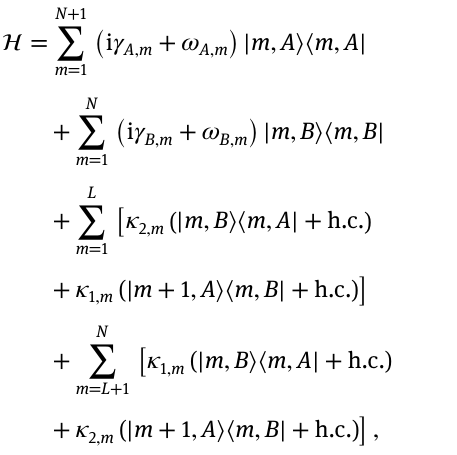
1 expresses gain gain